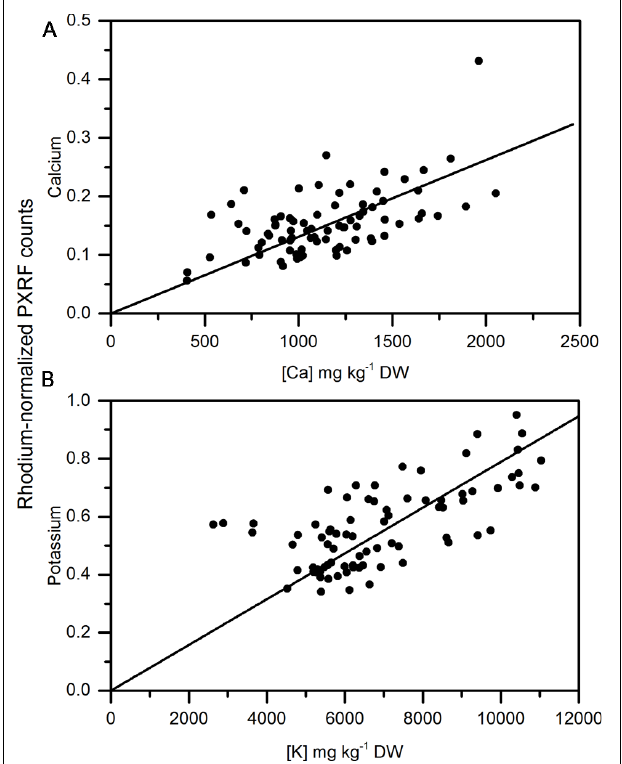
FIGURE 5 | Correlation of non-destructive, semi-quantitative mean (A) calcium and (B) Potassium content of pelletized, ground apple cortex tissue compared to corresponding MP-AES analysis of calcium. ( N =